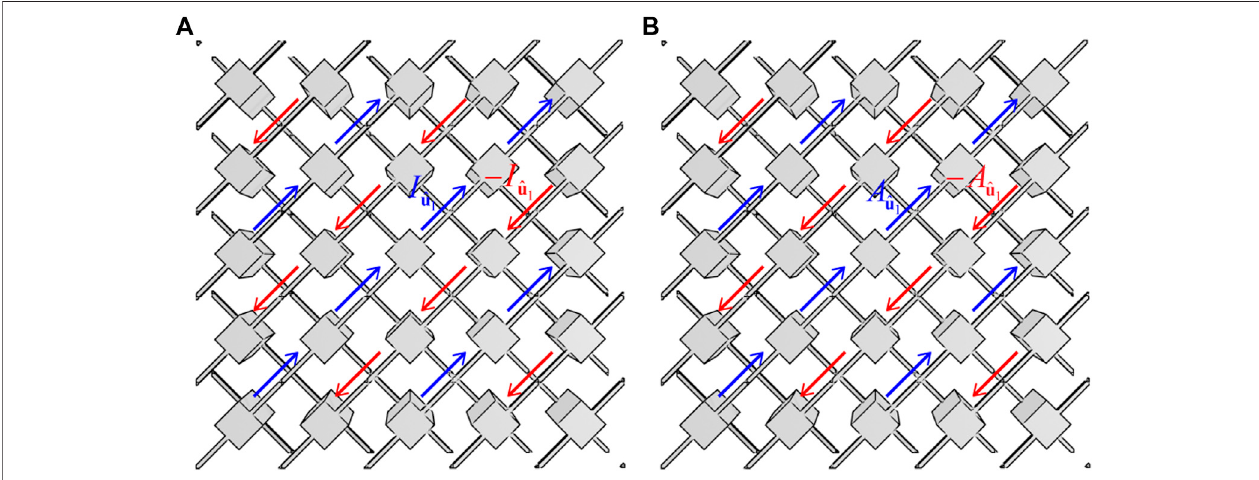
FIGURE 3 | Periodic distributions of (A) currents and (B) the current-induced vector potentials on the double-mesh MM. Since the quasistatic mode is located at Brillouinzonecorner M ,theelectriccurrentsonthetwomeshesareoutofphase(blueandred)andsodothevectorpotentialstheyinduce.Theinductance L ^ u as the ratio between this vector potential distribution and the current